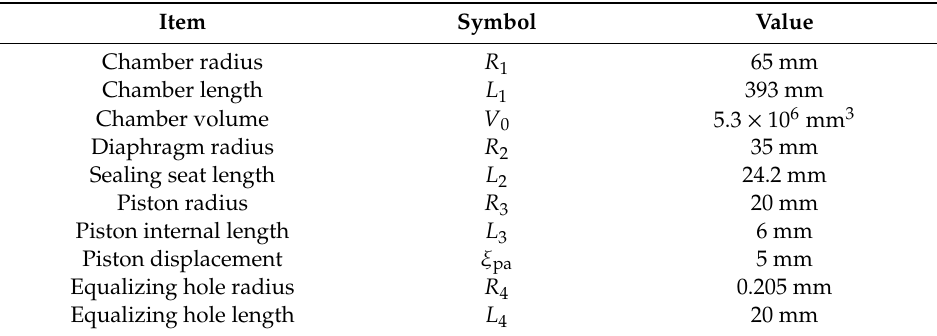
Table 1. Properties of the laser pistonphone.